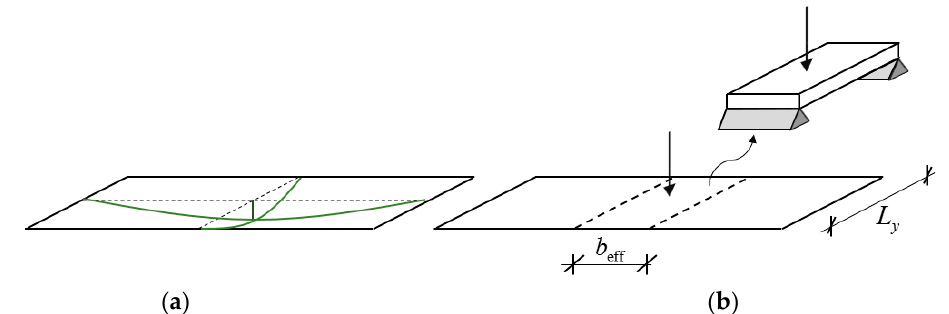
Figure 1. First eigen mode of a long plate ( a ) and the concept of effective width ( b ).